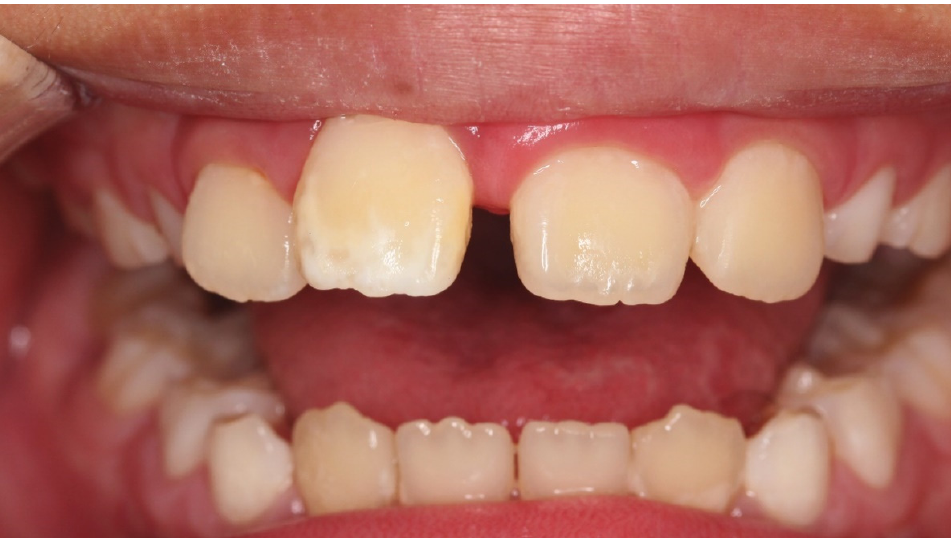
Figure 7. Case 2: Intraoral photograph after seven-times treatment. Table 2. In Case 2, the cloudiness and brown areas from the pre-treatment (before applications) and post-treatment (after seven applications) images were measured as pixels by digital image analysis. The analysis was performed three times, and the mean and standard deviations of the measure- ments were calculated (mean ± SD). The significance of the differences in areas before and after treatment was evaluated with p- values by t- test.